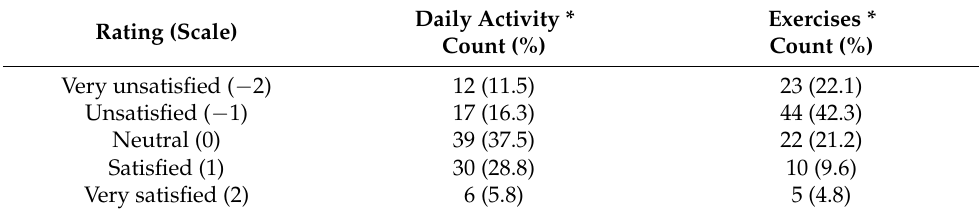
Table 3. Perceived comfort (PC) of wearing face masks .